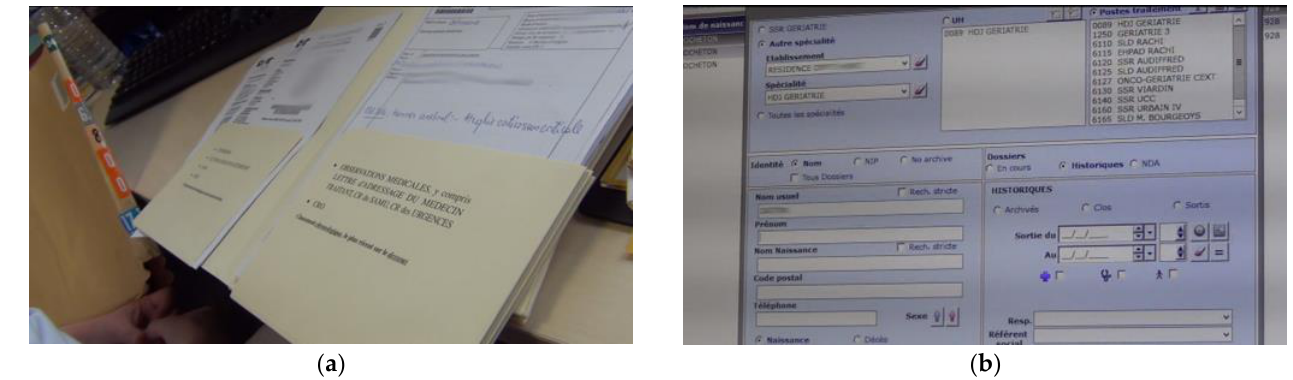
Figure 3. ( a ) Paper patient record on desk, next to keyboard; and ( b ) screenshot of electronic system .